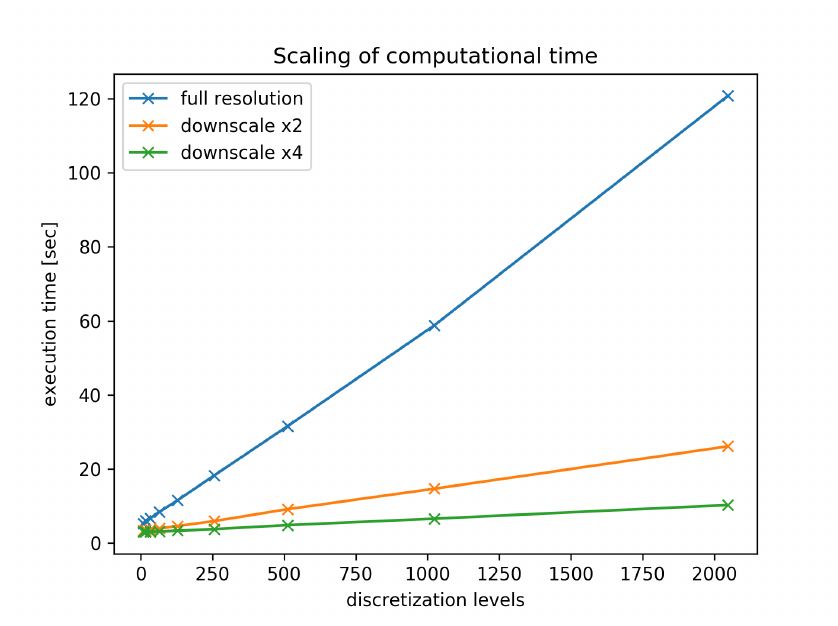
Figure 13. Approximate execution time scales with the number of pixels and the number of discretization levels plus a constant overhead because of data pre- and